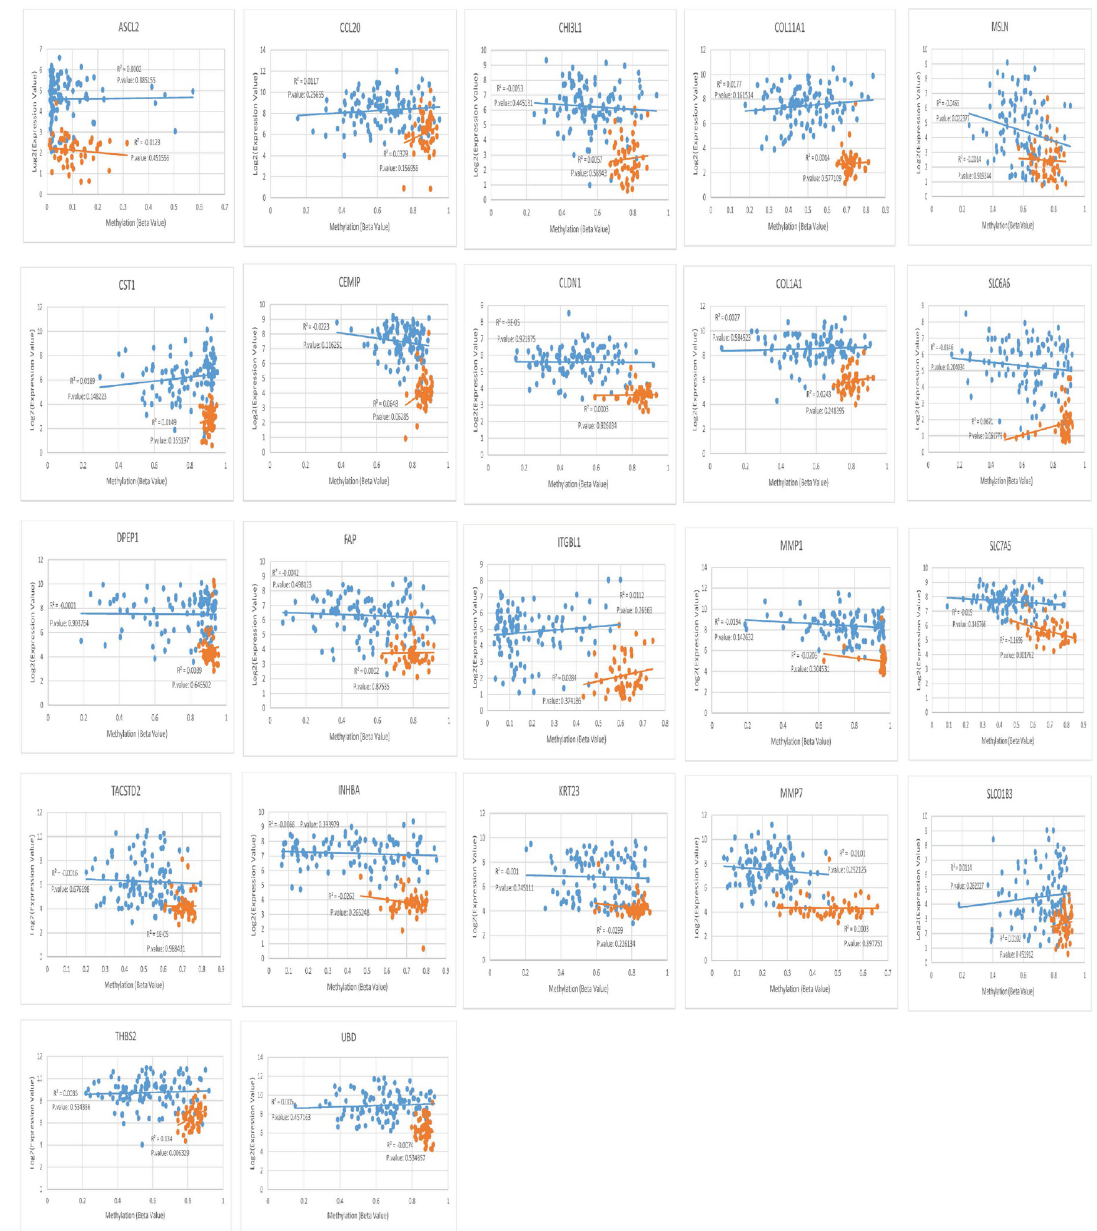
Fig 10. Correlation plots as for over-expressed/hypo-methylated validated Differentially Expressed Genes-Differentially Methylated Genes (vDEGs-DMGs).